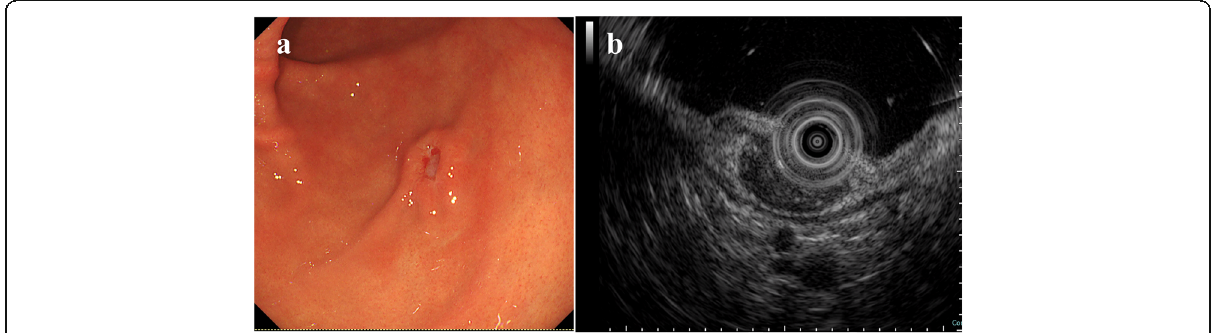
Fig. 1 EGD and EUS findings. A EGD showed that a tumor with small ulcer located on the greater curvature of the gastric angle. B EUS revealed a hypoechoic mass mainly in the third layer